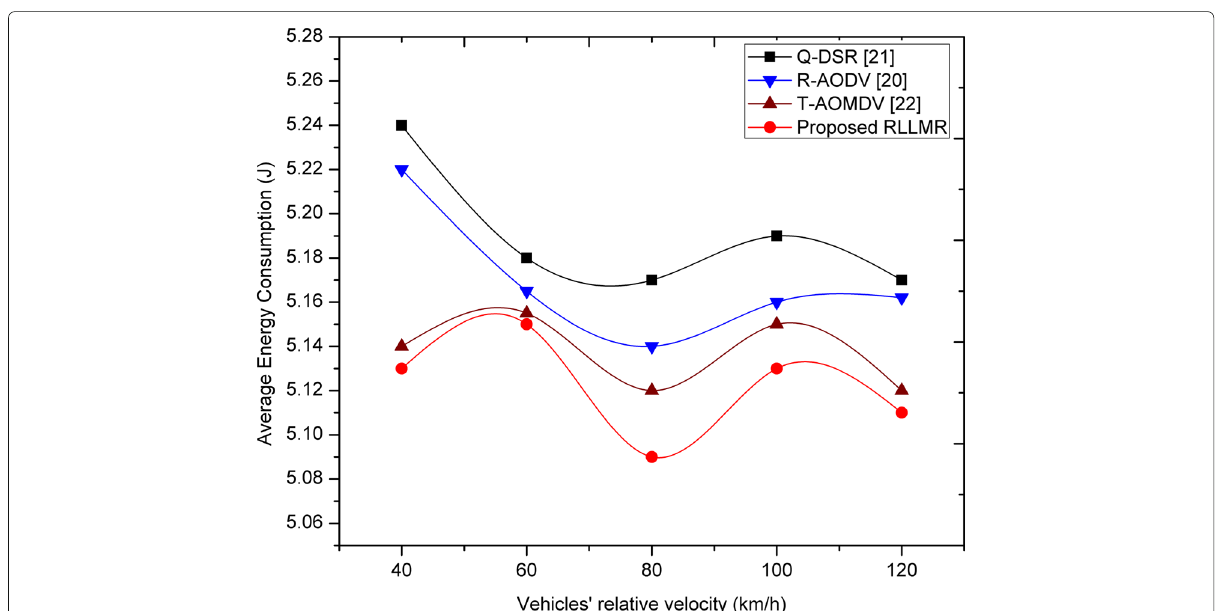
Fig. 16 Effect of different velocities over average energy consumption (nodes 50, R 1000 m, sig 5 km/h, t 10